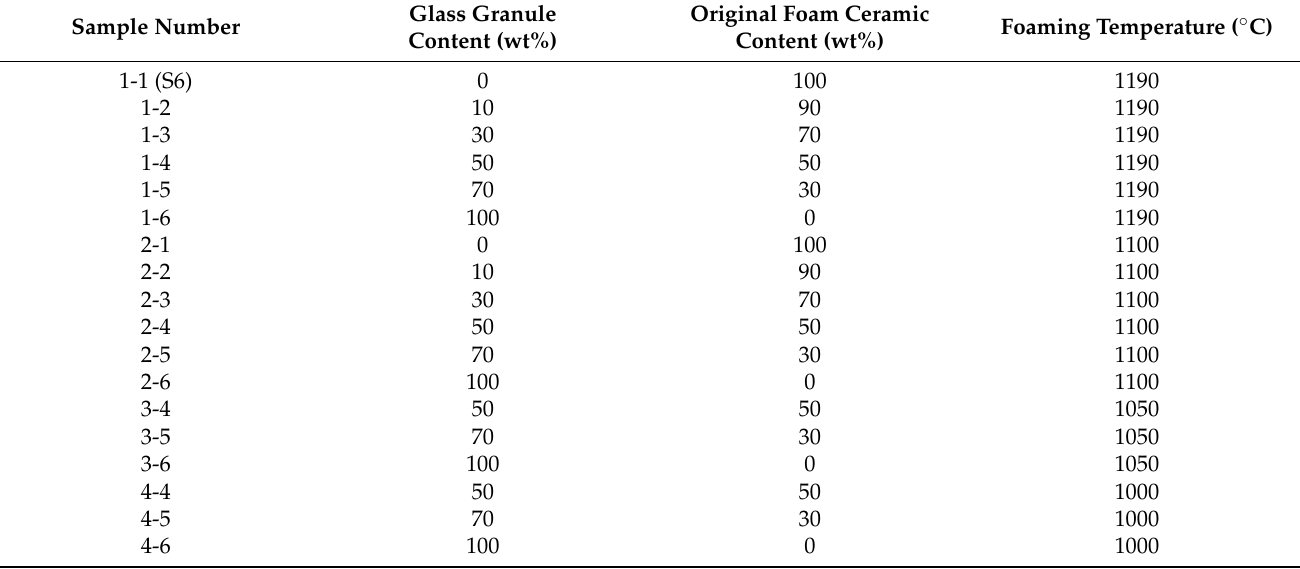
Table 4. Preparation parameters for the microcrystalline foam ceramic